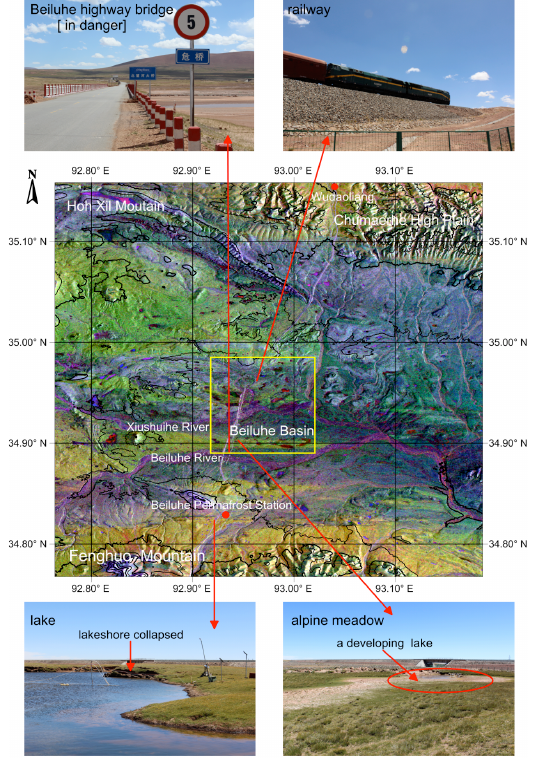
Figure 1. A false-color composited image ASAR intensity images and photos in study area. The over-layered contours are obtained from SRTM-DEM with an interval of 100 m and the yellow rectangular denote the location of study